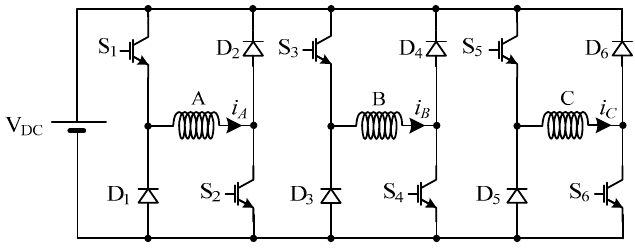
Figure 2. Asymmetrical half-bridge topology (AHB).